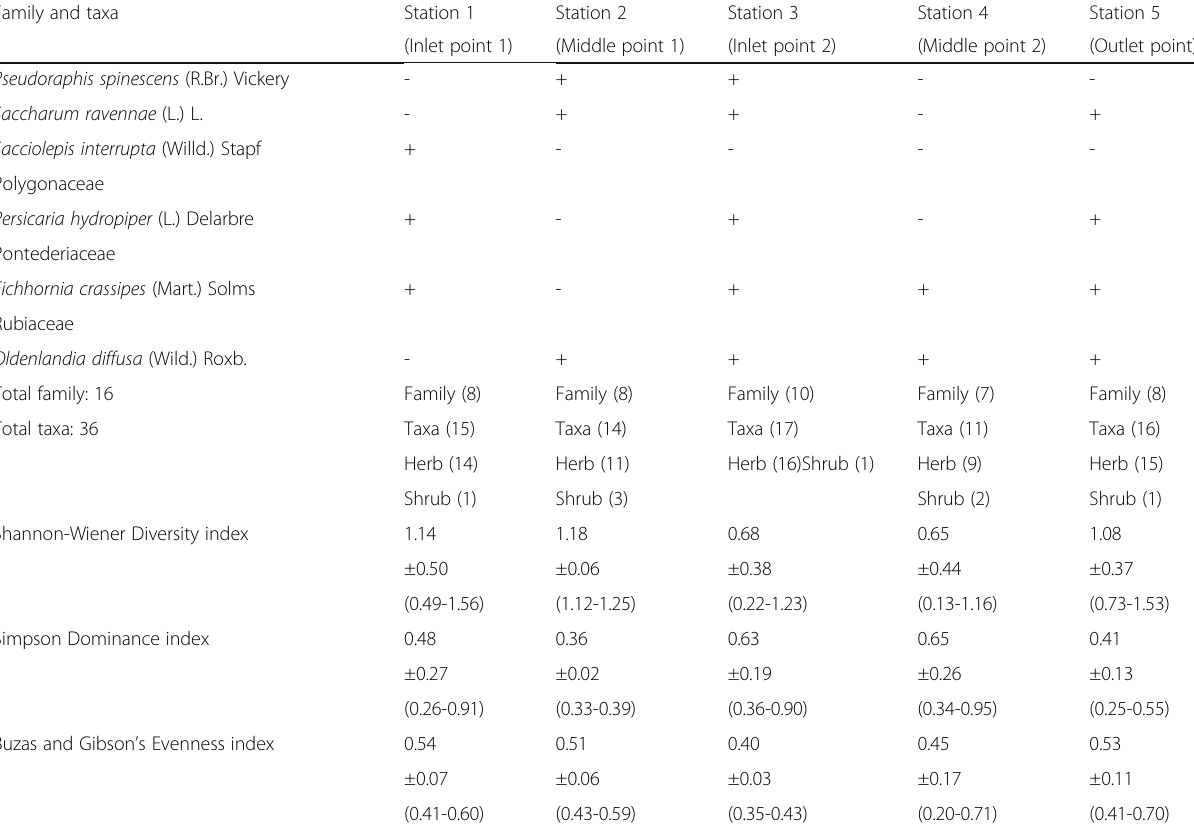
Table 1 Distribution and diversity profile of vegetation in the wetland across different sampling stations (Continued) Family and taxa